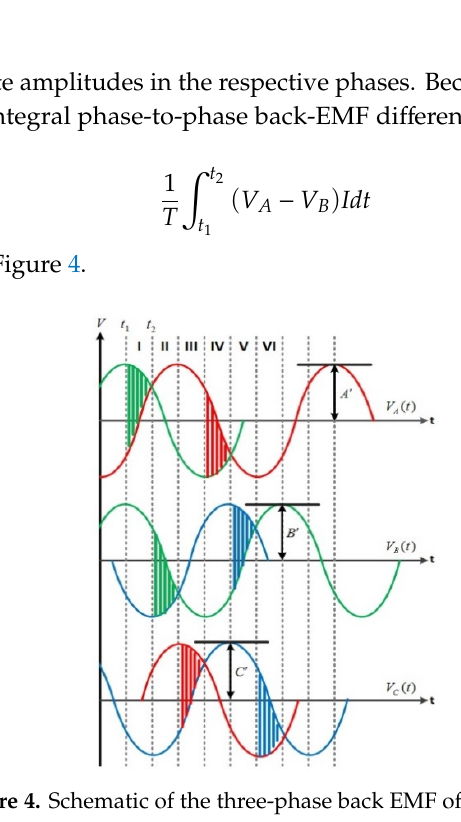
Figure 5. Circuit diagram of the system in the braking mode.